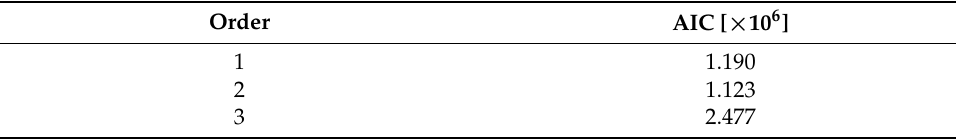
Table 2. AIC of a 30-class MC for (cid:96) ∈ { 1,2,3 } using the training set in